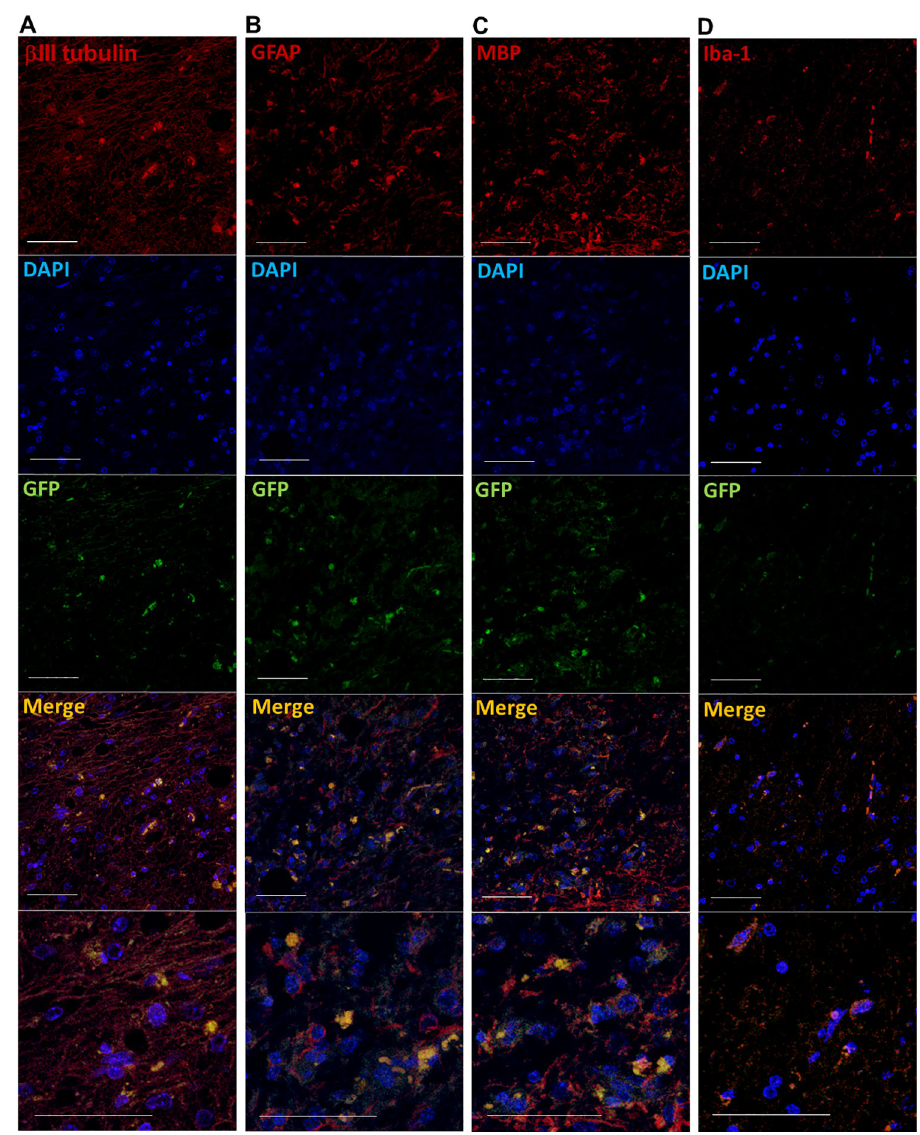
Fig 4. Immunofluorescence staining of the severed spinal cord implanted with HAP stem cells. Immunofluorescence staining shows that in the joined area of the previously severed spinal cord, the implanted HAP stem cells differentiated to neurons (A), astrocytes (B), oligodendrocytes (C). Microglia were GFP negative in the joined area of severed spinal cord (D). Red = β III tubulin (A), GFAP (B), MBP (C) or Iba-1 (D); Green = GFP (A-D); Blue = DAPI (A-D); Merged (A-D). Bar = 50 μ m. All images show sagittal sections of the spinal